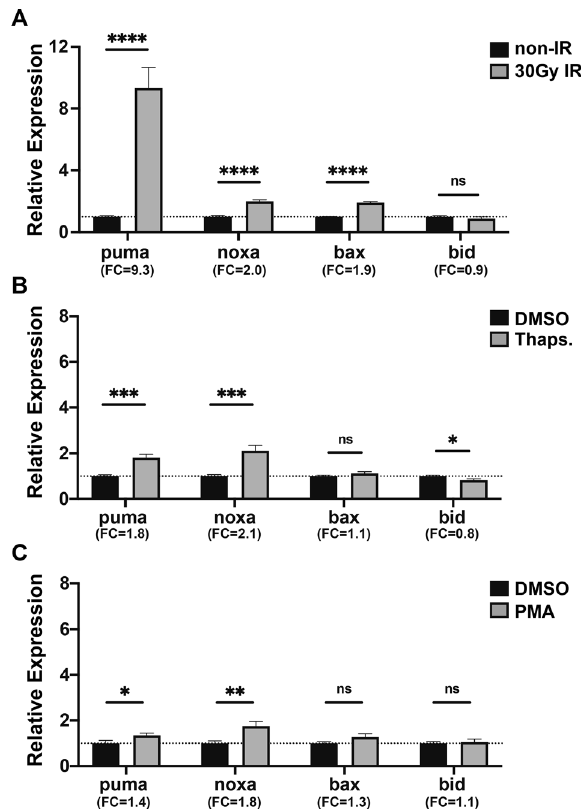
Fig. 1 Quantitative real-time PCR (qRT-PCR) analysis of pro- apoptotic markers after IR- and drug-induction in wild-type zebra fi sh embryos. 24 hpf zebra fi sh embryos were treated with A 30 Gy IR-irradiation, B 5 μ M Thapsigargin (Thaps.), and C 3.3 μ M Phorbol 12-myristate 13-acetate (PMA); and qRT-PCR was performed at 6 h ( A ) or 4 h ( B , C ) after treatment. Expression levels were normalized to GAPDH. n = 9 ( A , B ) and n = 7 ( C ) from ~30 pooled embryos per sample. Bars represent mean ± SEM. * p < 0.05; ** p